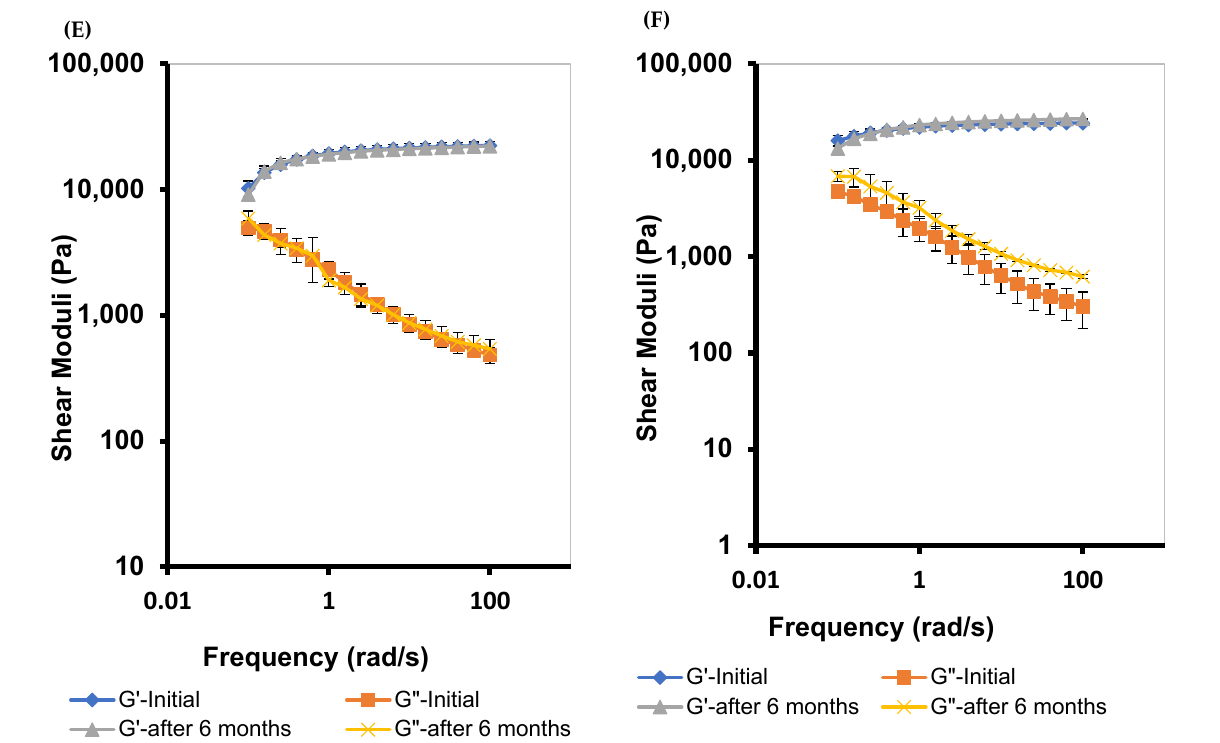
Figure 12. Frequency-dependent elastic (G ′ ) and viscous (G ″ ) moduli of: ( A ) M2, ( B ) M3, ( C ) M4, ( D ) M5, ( E ) M6, and ( F ) M7 microgels after six months of storage at room temperature.